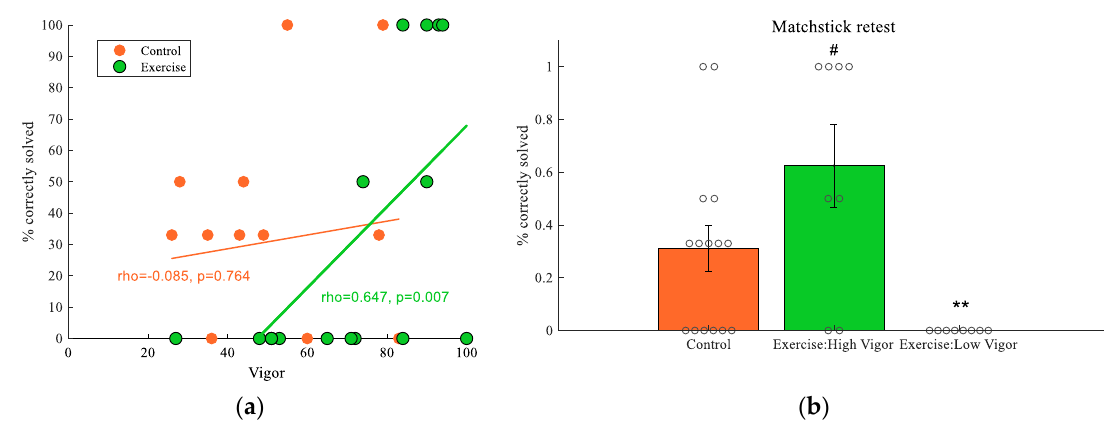
Figure 5. Exercise effect on matchstick re-test affected by vigor. ( a ) Scatterplot of the association (with a regression line) between post-intervention vigor and matchstick re-test score in each group; ( b ) comparison of matchstick re-test score between control and the two exercise groups (created based on a median split of vigor). **, p < 0.01; # p = 0.081, compared to control. Data shown as means ± SE, circles represent individual responses.